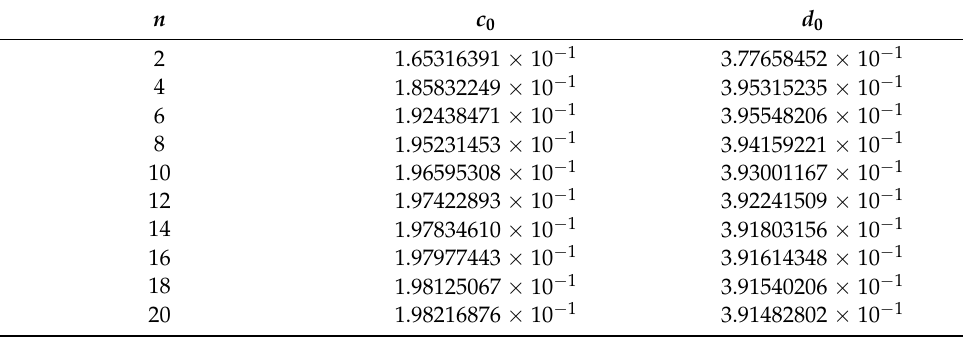
Table 1. Numerical values of c 0 and d 0 at different n when H = 300